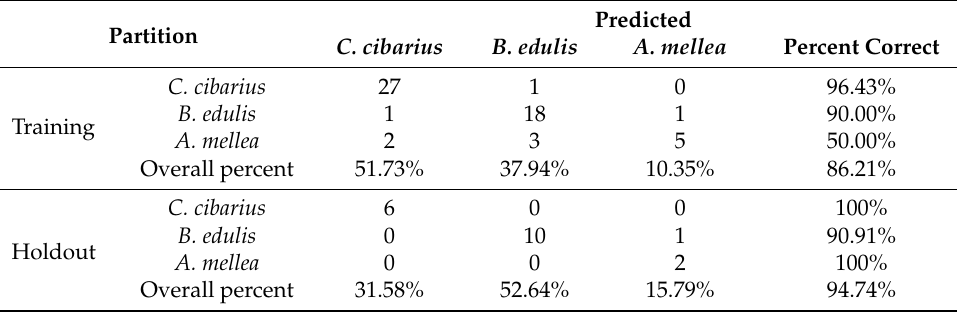
Table 1. Classification table of mushroom samples, obtained after kNN